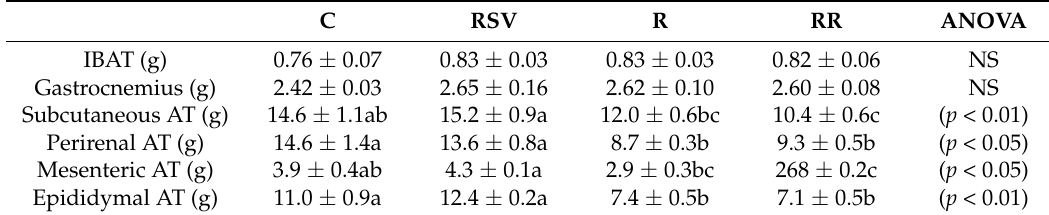
Table 1. Weights of IBAT, gastrocnemius muscle and subcutaneous, perirenal, mesenteric and epididymal adipose tissues of rats fed on the experimental diets for 6